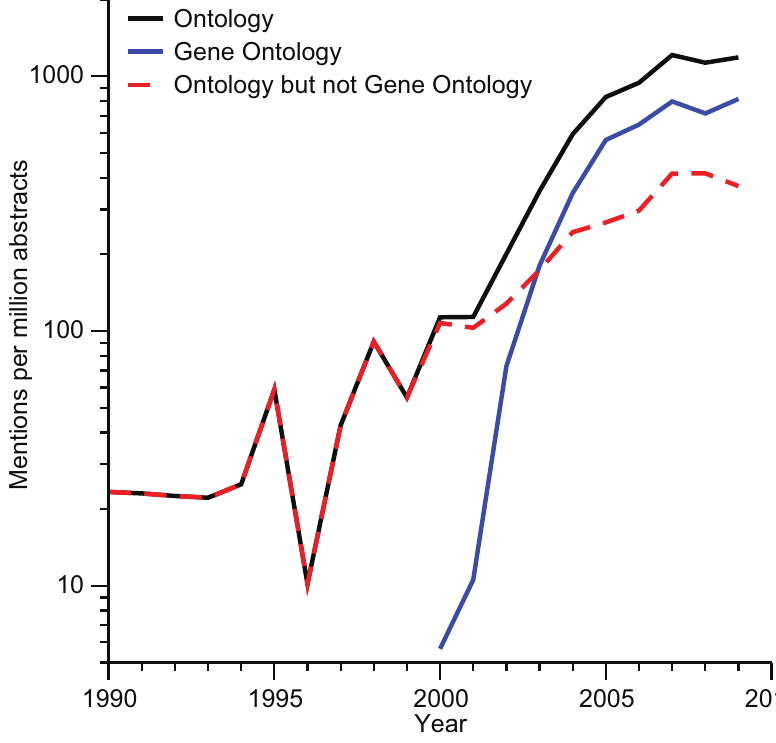
Figure 2. The growth of ontologies in biomedicine. To illustrate the increasing use of ontologies, we mined PubMed abstracts for occurrences of the words ontology and gene ontology (and the plural forms thereof). We normalized for the general growth of PubMed by converting the raw counts per year to ‘‘hits per million abstracts.’’ The plot shows a steady increase in the awareness of ontologies over the past decade, and that GO became the dominating biological ontology over a period of just five years (note the logarithmic scale). However, ontologies appear to have reached a plateau over in the past three years, at least in terms of how often they are mentioned in abstracts. In contrast, the citations to GO and associated resources are steadily rising (end of 2009 . 5500) and imply a further increasing use.